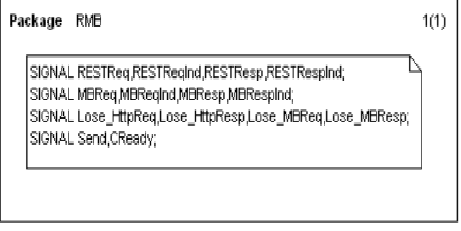
Figure 2: Declaration of all signals used